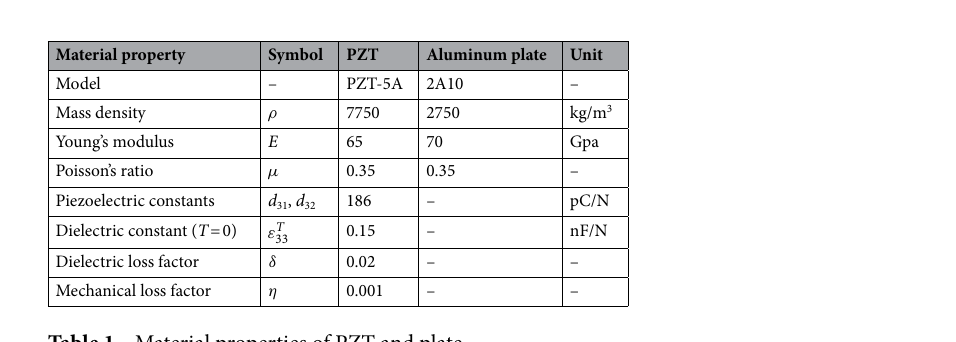
Table 1. Material properties of PZT and